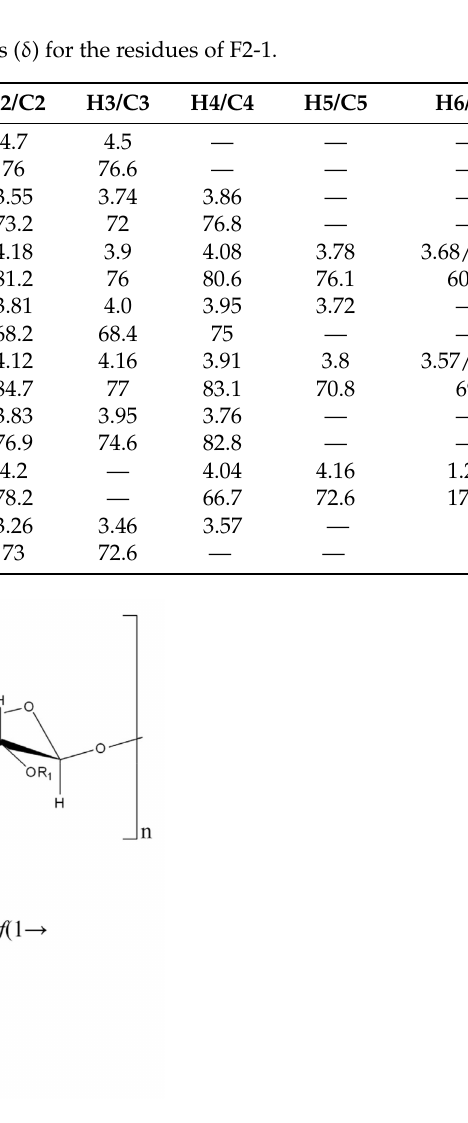
Figure 4. The possible structure of F2-1. Sulfated galactan, which was composed preponderantly of 4-sulfated, 3-linked β -D- galactopyranosyl units, was found in C. isthmocladum in braizle. Ara and Man were also found in other polysaccharide fractions of this species. However, the structures of these heteropolysaccharides were not elucidated. In this paper, we found a very different poly- Saccharide that contained galactofuranose from the same species. Our finding ex- panded the polysaccharide composition of this species [19]. Galactofuranose with a high structural diversity has been proposed as a chemo- taxonomic character. A water-soluble, sulfated xylogalactoarabinan from the green sea- weed, Cladophora falklandica , shows similar structural characteristics. The xylogalactoara- binans also have a backbone of four linked β -L-arabinopyranose units partially